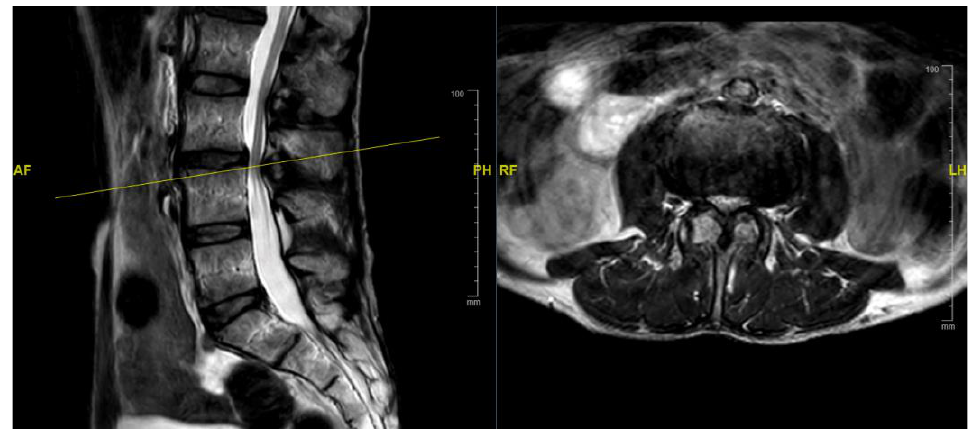
Figure 3. MRI lumbar spine, sagittal ( left ) and axial ( right ) cuts, showing grade I spondylolisthesis and associated moderate-severe stenosis at L3–4.